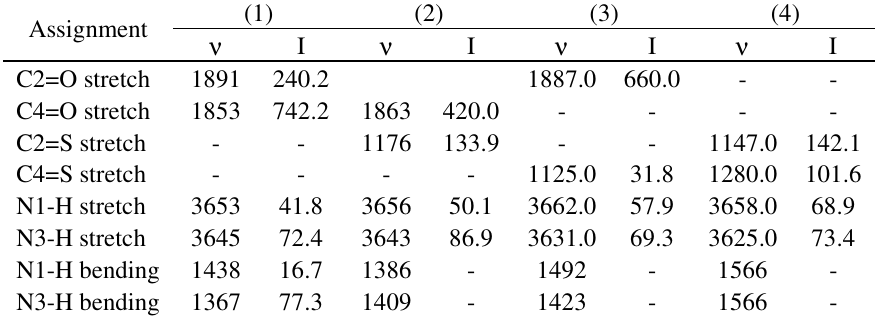
Table 4. Harmonic vibrational frequencies ( ν =cm -1 ) and infrared intensities (I) of the different 5-methyl-2,4-oxo/thio-imidazolidine compounds